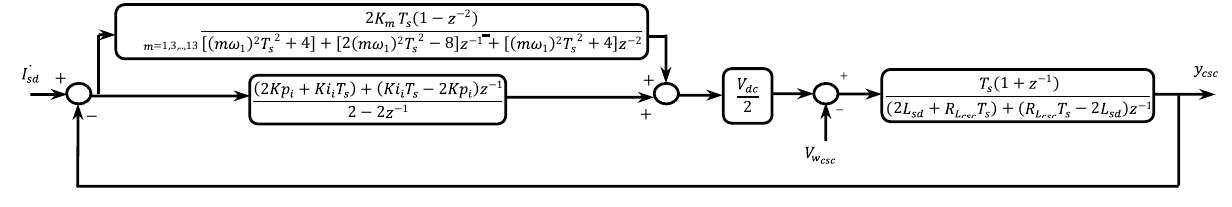
Figure 5. The CSI controller block